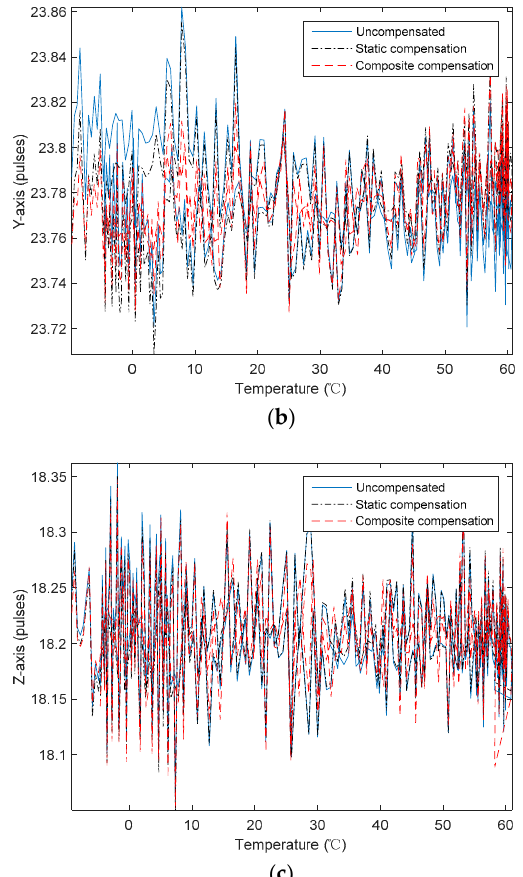
Figure 7. The RLG’s bias curve with static and composite temperature model compensation. ( a ) X -axis of gyro; ( b ) Y -axis of gyro; ( c ) Z -axis of gyro.